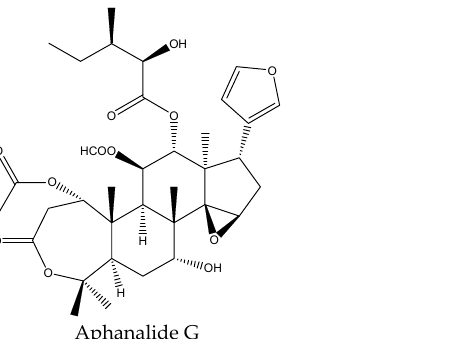
Figure 5. The structures of ring A-seco chemicals.